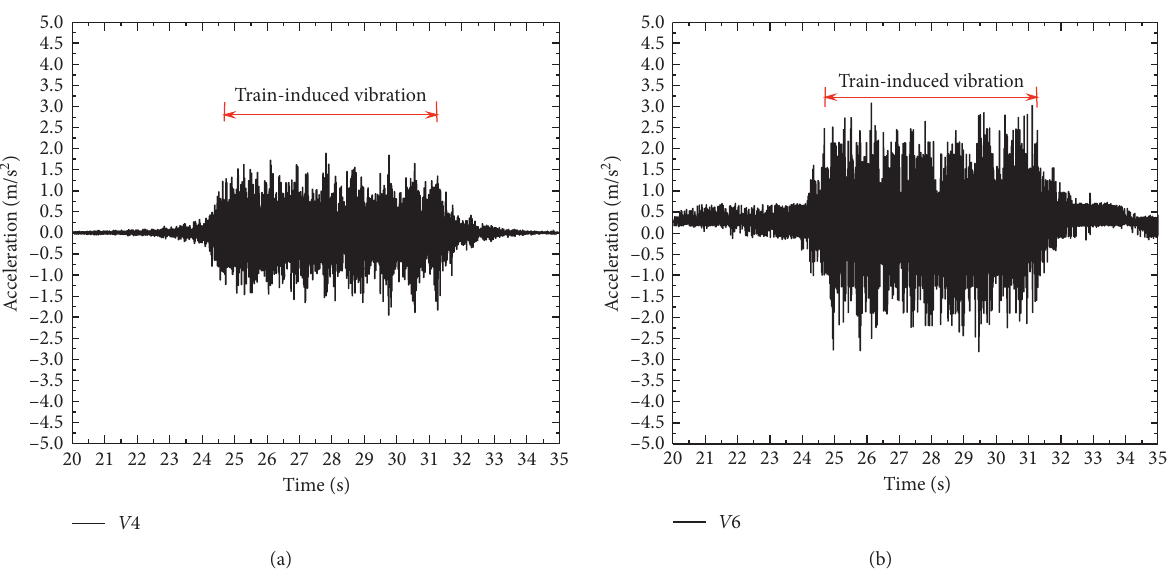
Figure 5: Vibration time histories for points (a) V 4 and (b) V 6 on the sound insulation